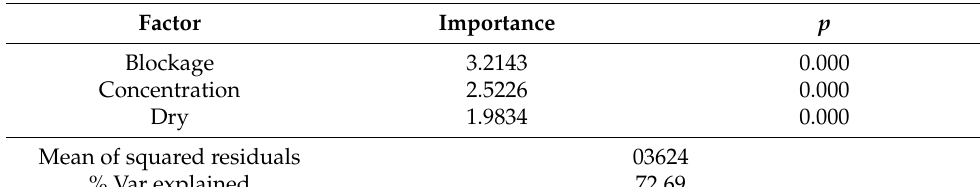
Table 5. Evaluation of the factor importance of the random forest model.